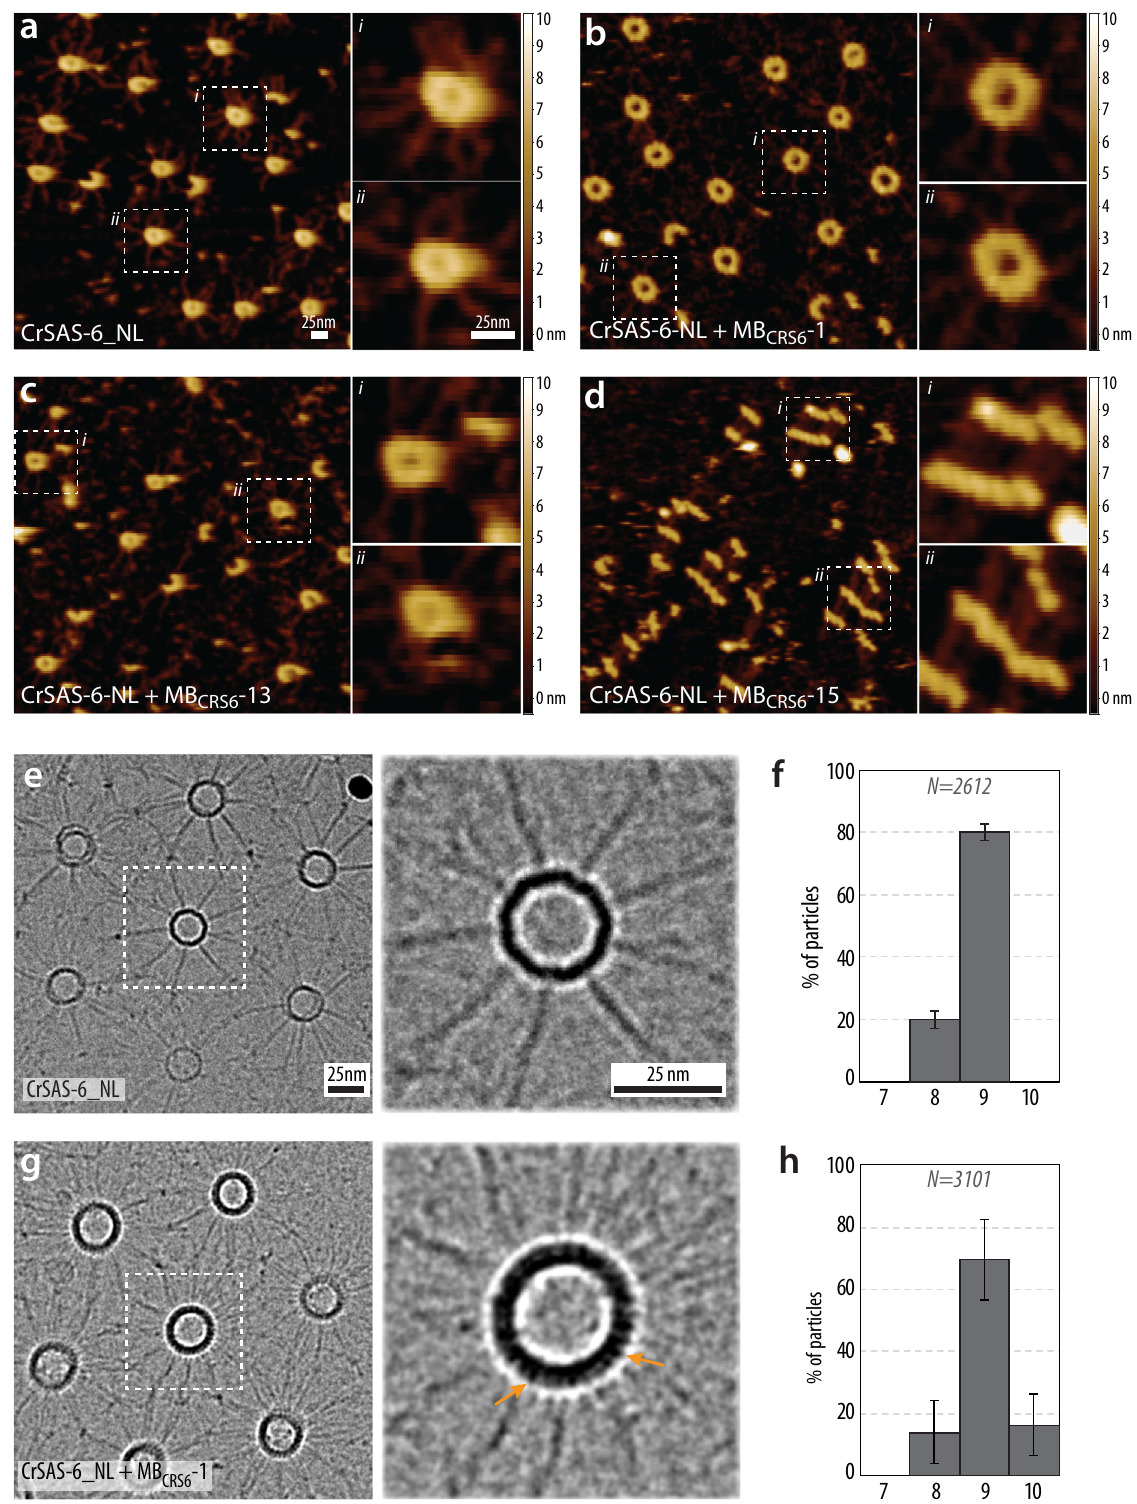
Fig. 2 PORT-HS-AFM and cryo-EM uncover impact of monobodies on CrSAS-6 ring assembly and stacking. a - d PORT-HS-AFM equilibrium analysis of CrSAS-6_NL alone ( a ), or together with MB CRS6 -1 ( b ), MB CRS6 -13 ( c ), or MB CRS6 -15 ( d ), with higher magni fi cation views on the right showing in each case two representative examples of assemblies. Scale bars: 25 nm; z scale color bar, – 0.5 to 10 nm. All measurements were performed at least twice, with at least 5 fi eld of view imaged in each experiment. e - h Transmission cryo-EM of ring stacking assay 42 and corresponding symmetry distributions based on particle classi fi cation of CrSAS-6_NL alone ( e , f ) or CrSAS-6_NL and a 50% molar excess of MB CRS6 -1 ( g , h ). Note that spokes can be dif fi cult to discern and be more numerous than 9, due to partially out of register stacking of SAS-6 ring polymers. The orange arrows point to protrusions observed on the outside of SAS-6 rings, corresponding to the density contributed by the monobody. Data represent mean ± SD. Particles numbers from at least